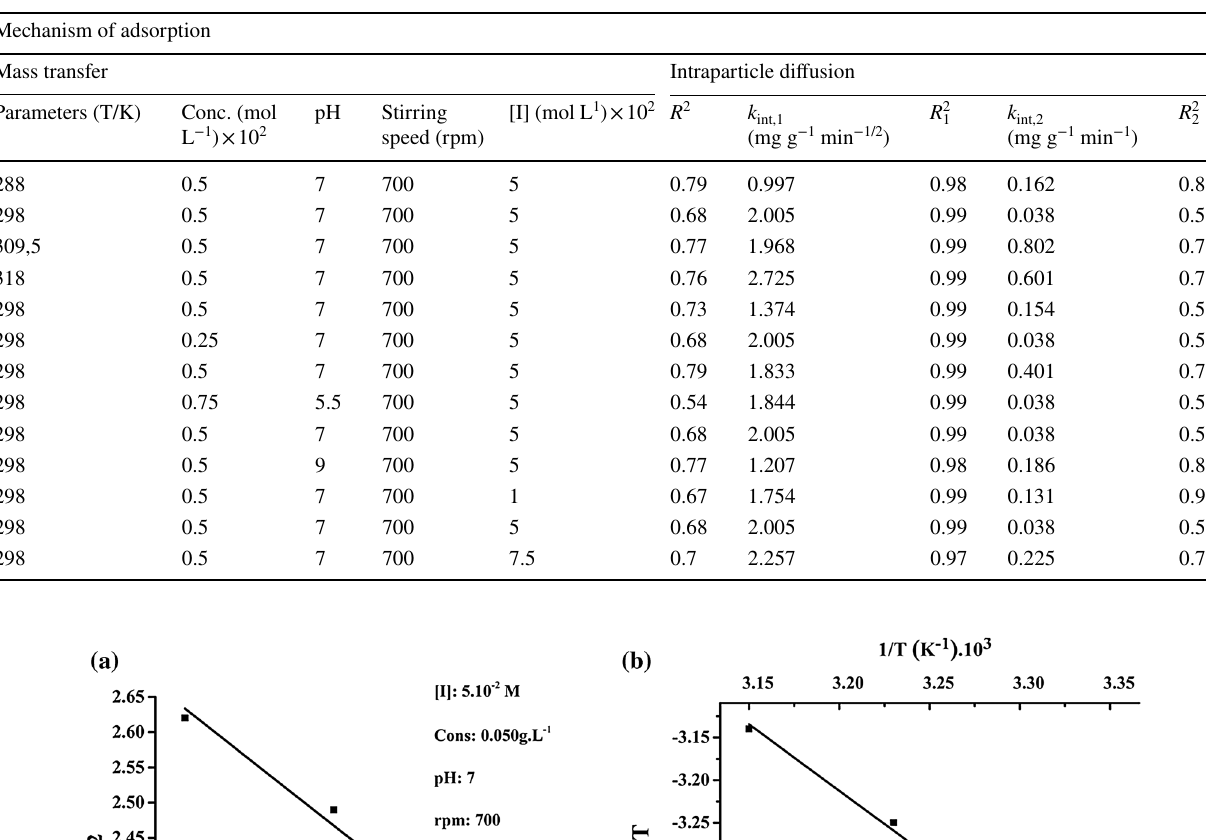
Table 4 Kinetic data calculated for adsorption of lipase enzyme on diatomite clay